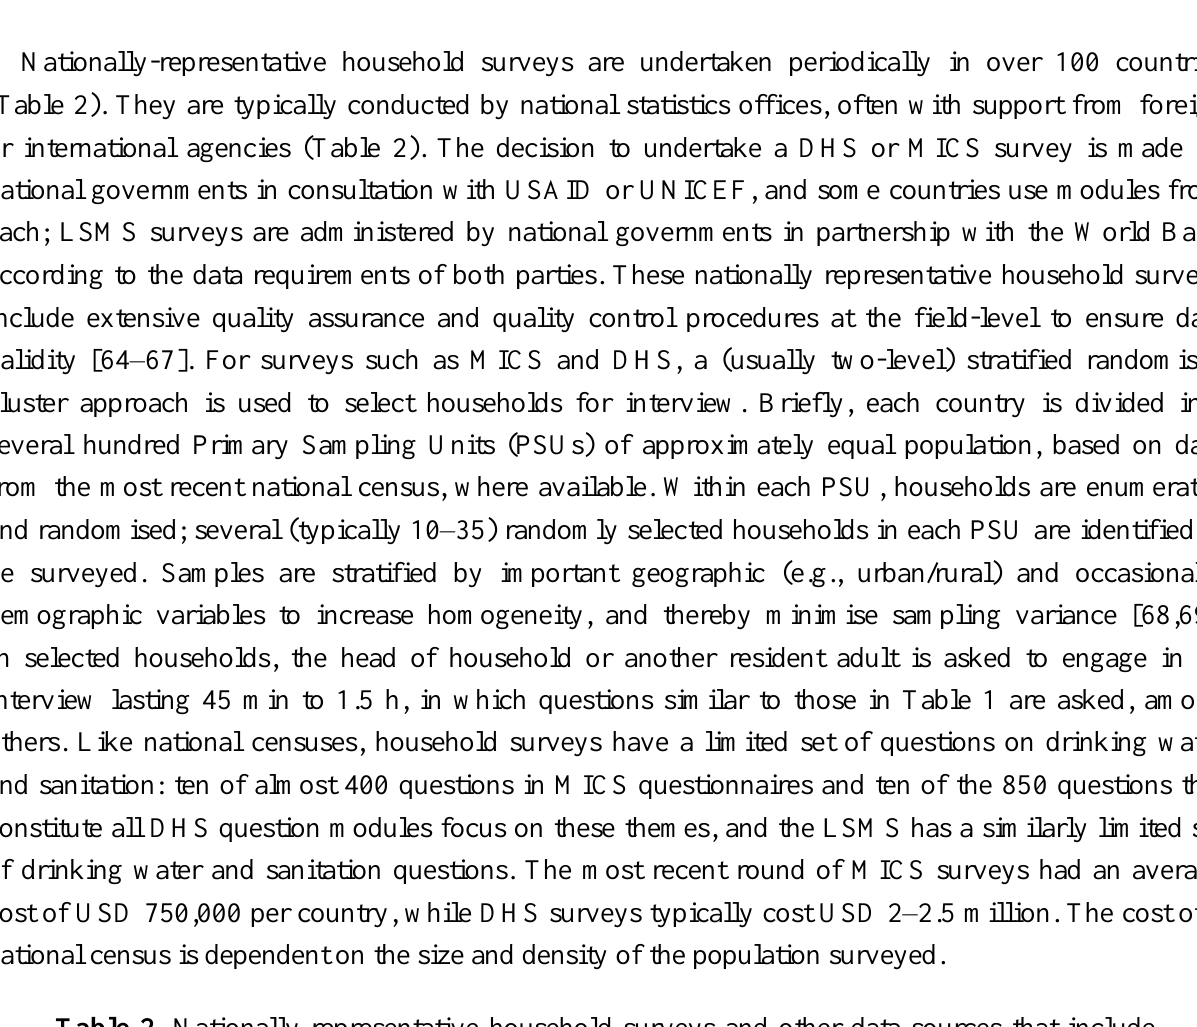
Table 2. Nationally representative household surveys and other data sources that include data related to drinking water and/or sanitation and are used by